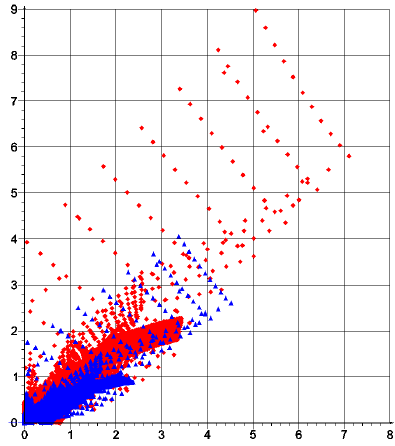
Figure 8. Distribution of optimal pairs of points ( k *, μ *) (blue triangles) and ( a */2, c */2) (red diamonds) for IMD and CMD method, respectively .